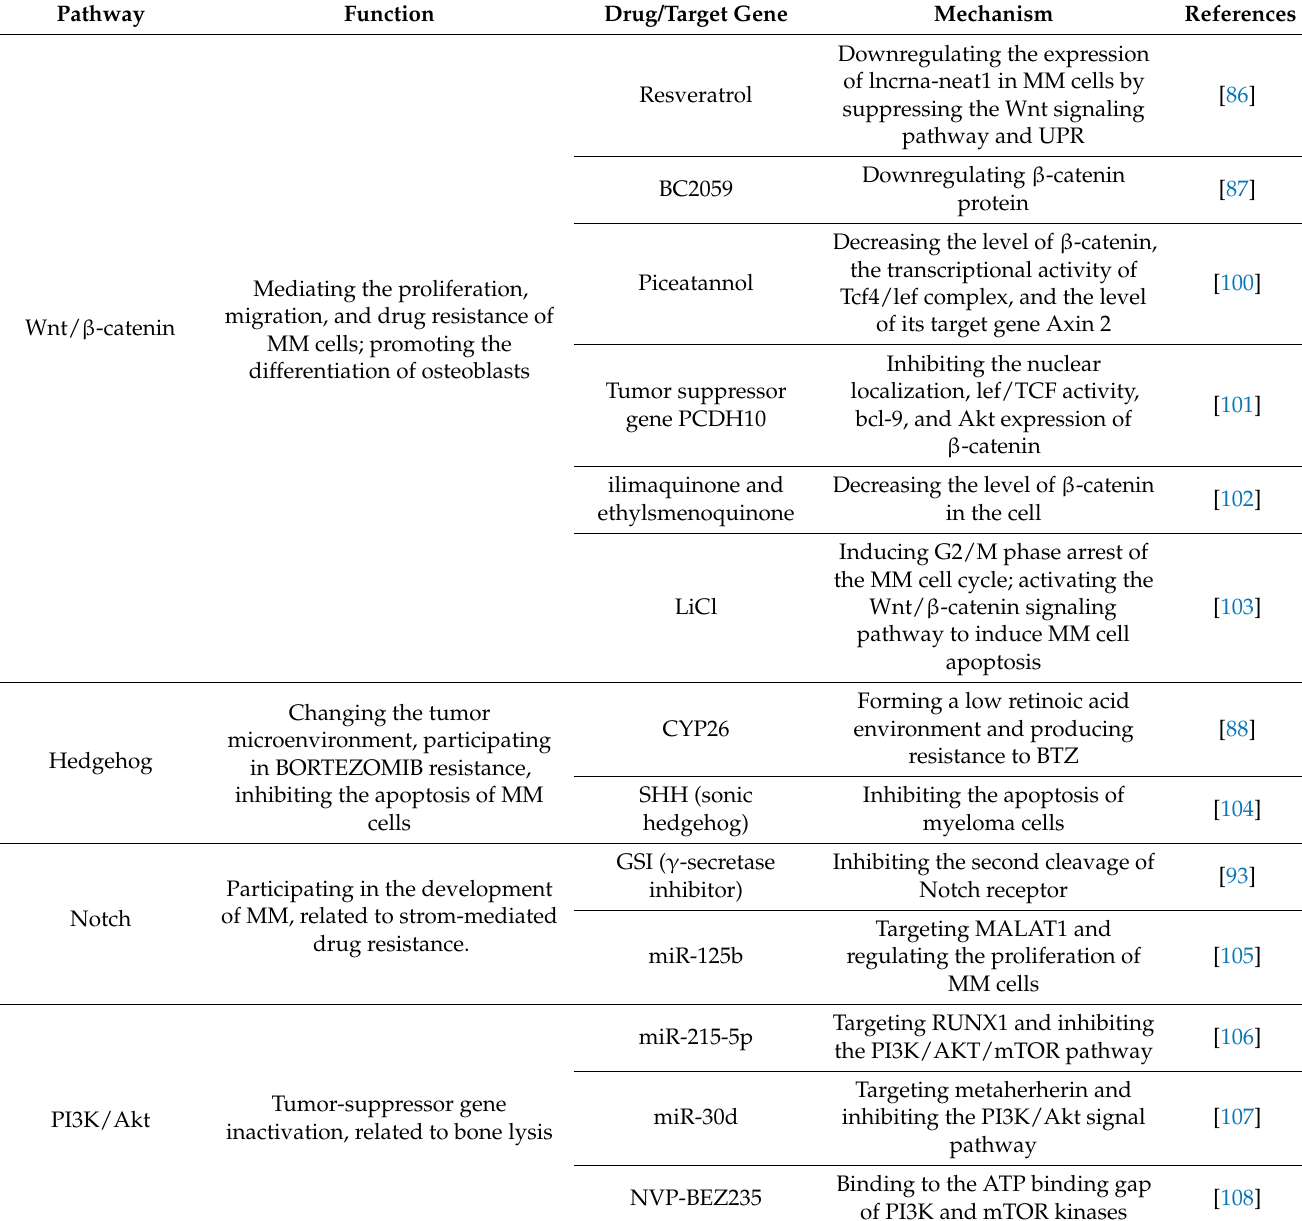
Table 2. Common pathway related to stemness in MM and corresponding